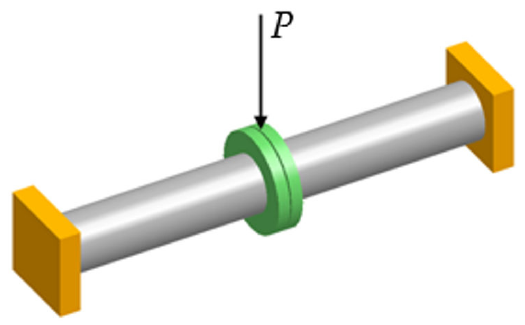
Figure 4. Model for the force value